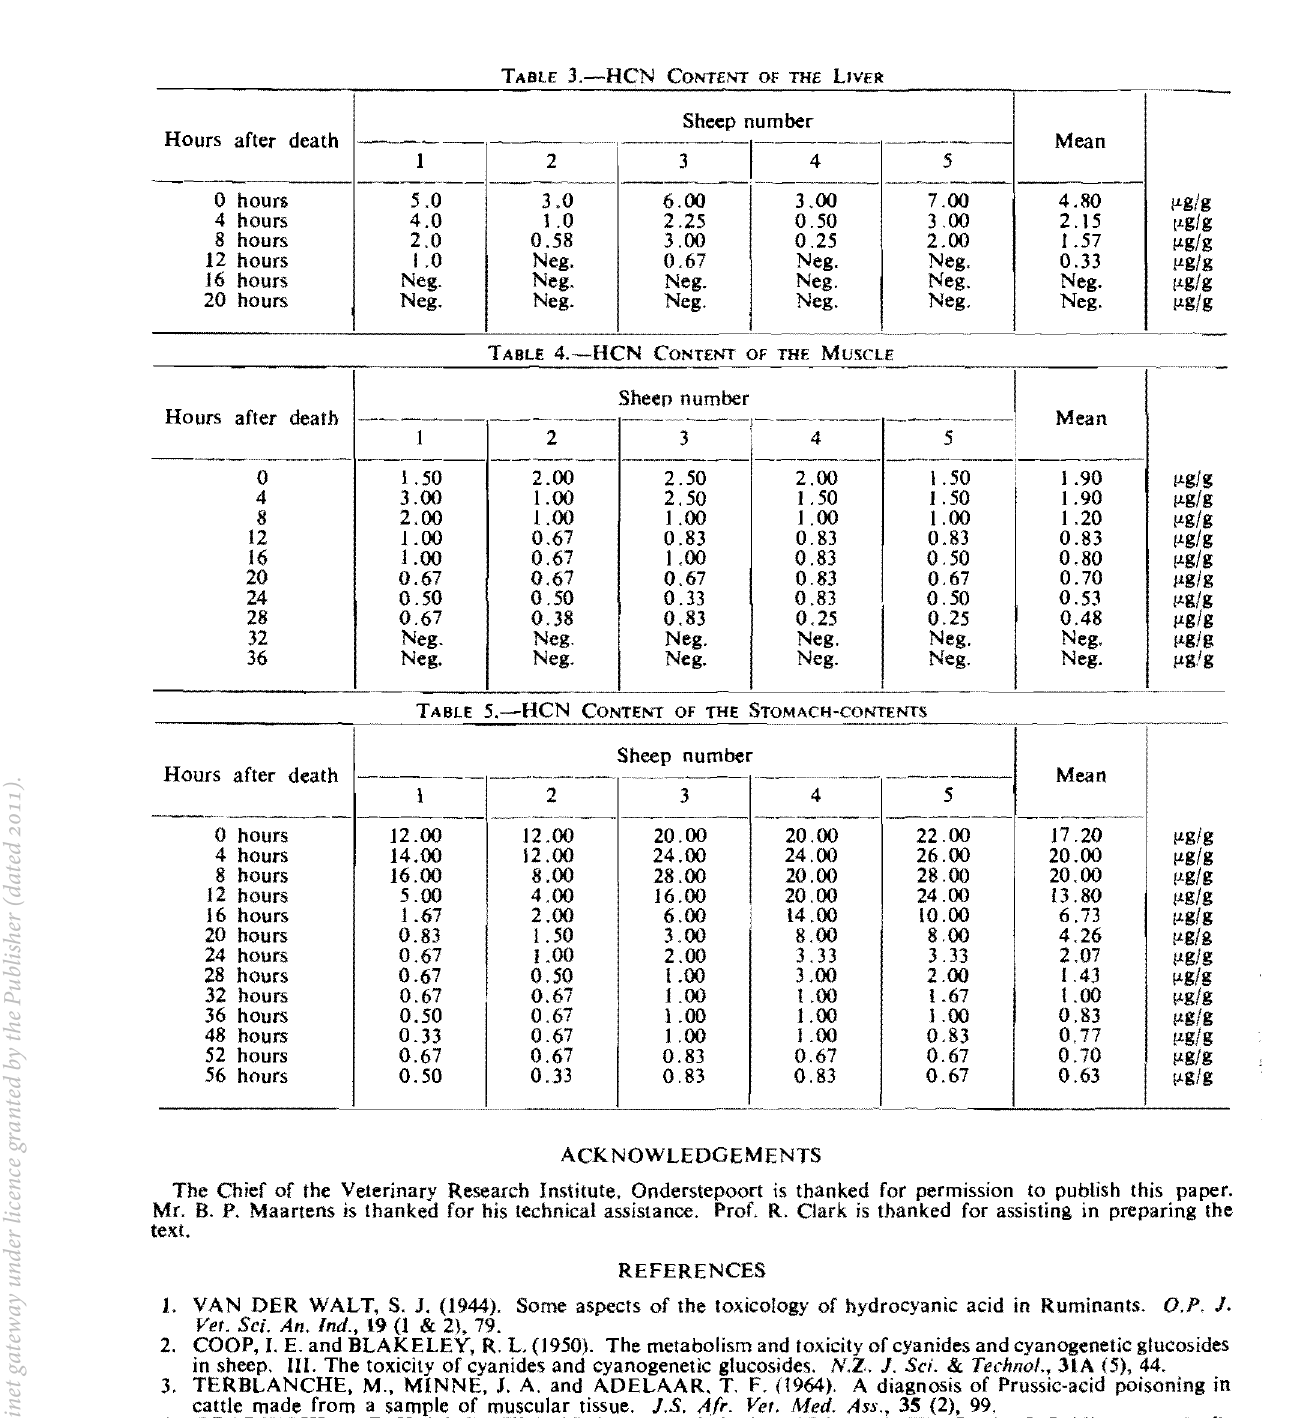
TABLE 3.-HCN CONTENT OF THE LIVER